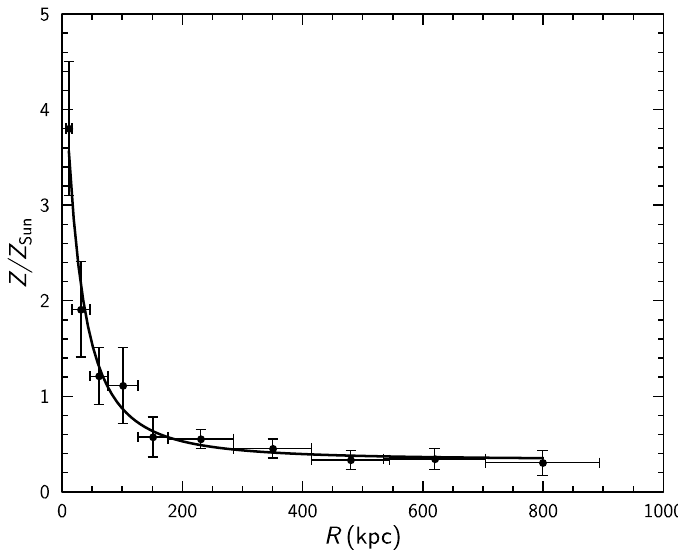
Fig. 2. The observed projected metalicity pro(cid:12)le of CLJ1415 in solar units and the corresponding (cid:12)t from DSDEPROJ . innermost bin ( ∼ 10 kpc) is K c = 12.1 ± 2.6 keV cm 2